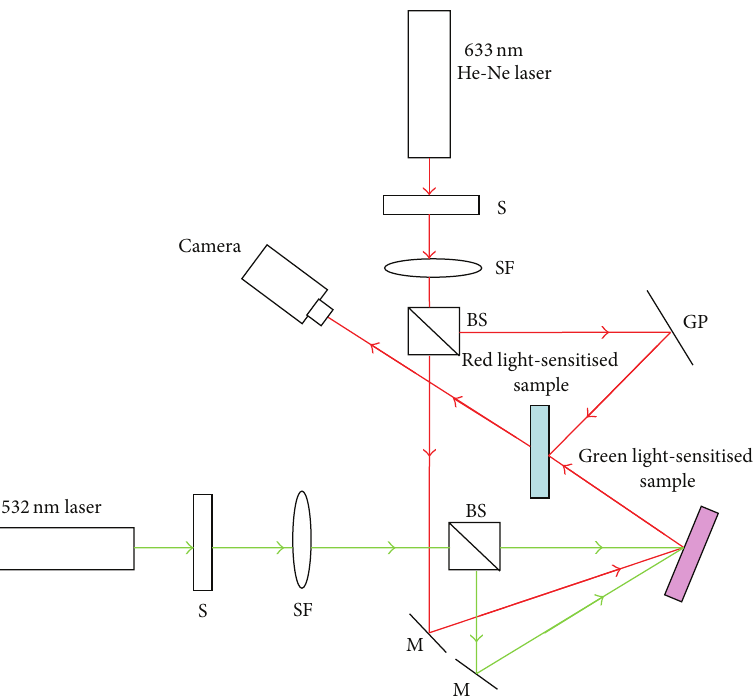
Figure 4: Holographic interferometry setup; S, shutter, SF, spatial filter, BS, beam splitter, GP, glass plate, and M, mirror.